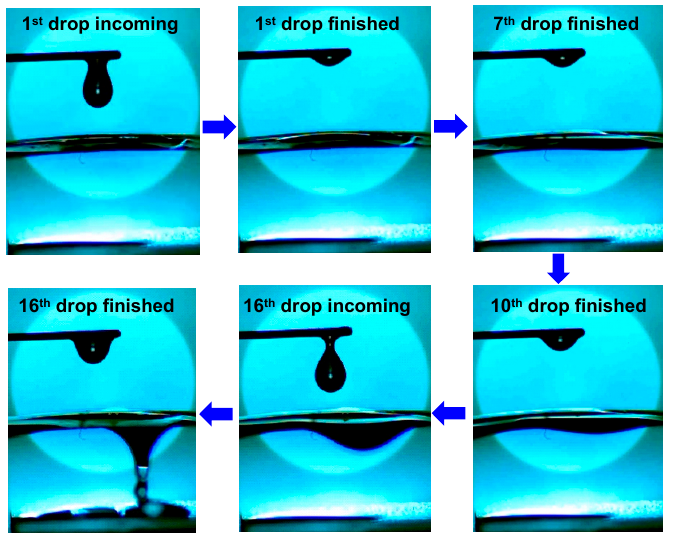
Figure 7. Snapshots of spreading and permeating behavior of high-viscosity oil (hydraulic oil: ~190 cP) droplets (~13 μ L) continuously dropped on the square (2 cm × 2 cm) 120 μ m thick electro- spun membrane that was obtained by heating collector/substrate up to 80 °C. The snapshots were clipped from a high-speed camera recording at 400 frames per second.